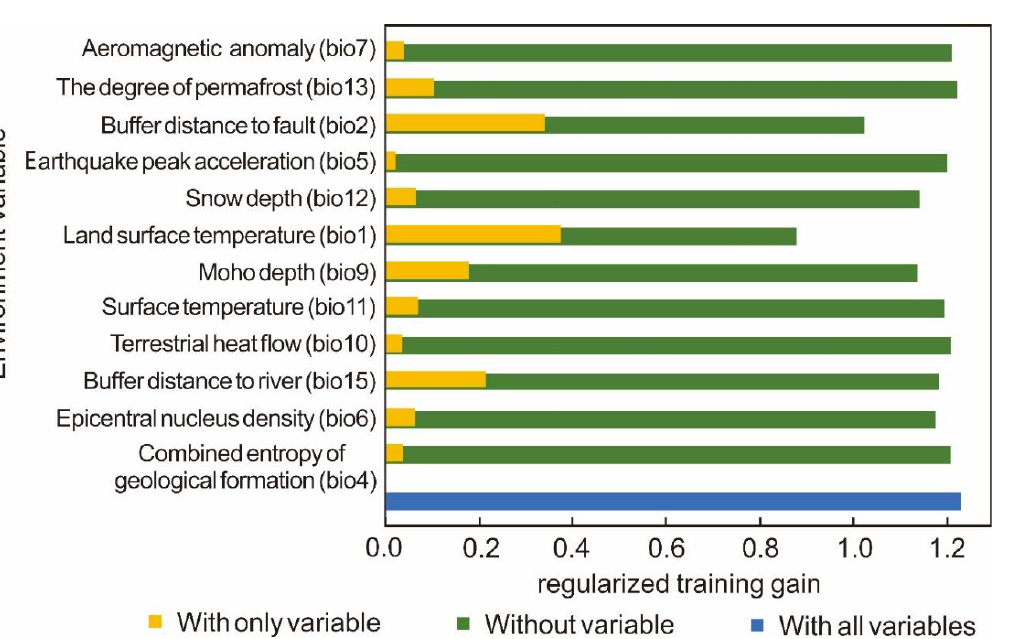
Figure 8. Jack-knife test of environmental variables.